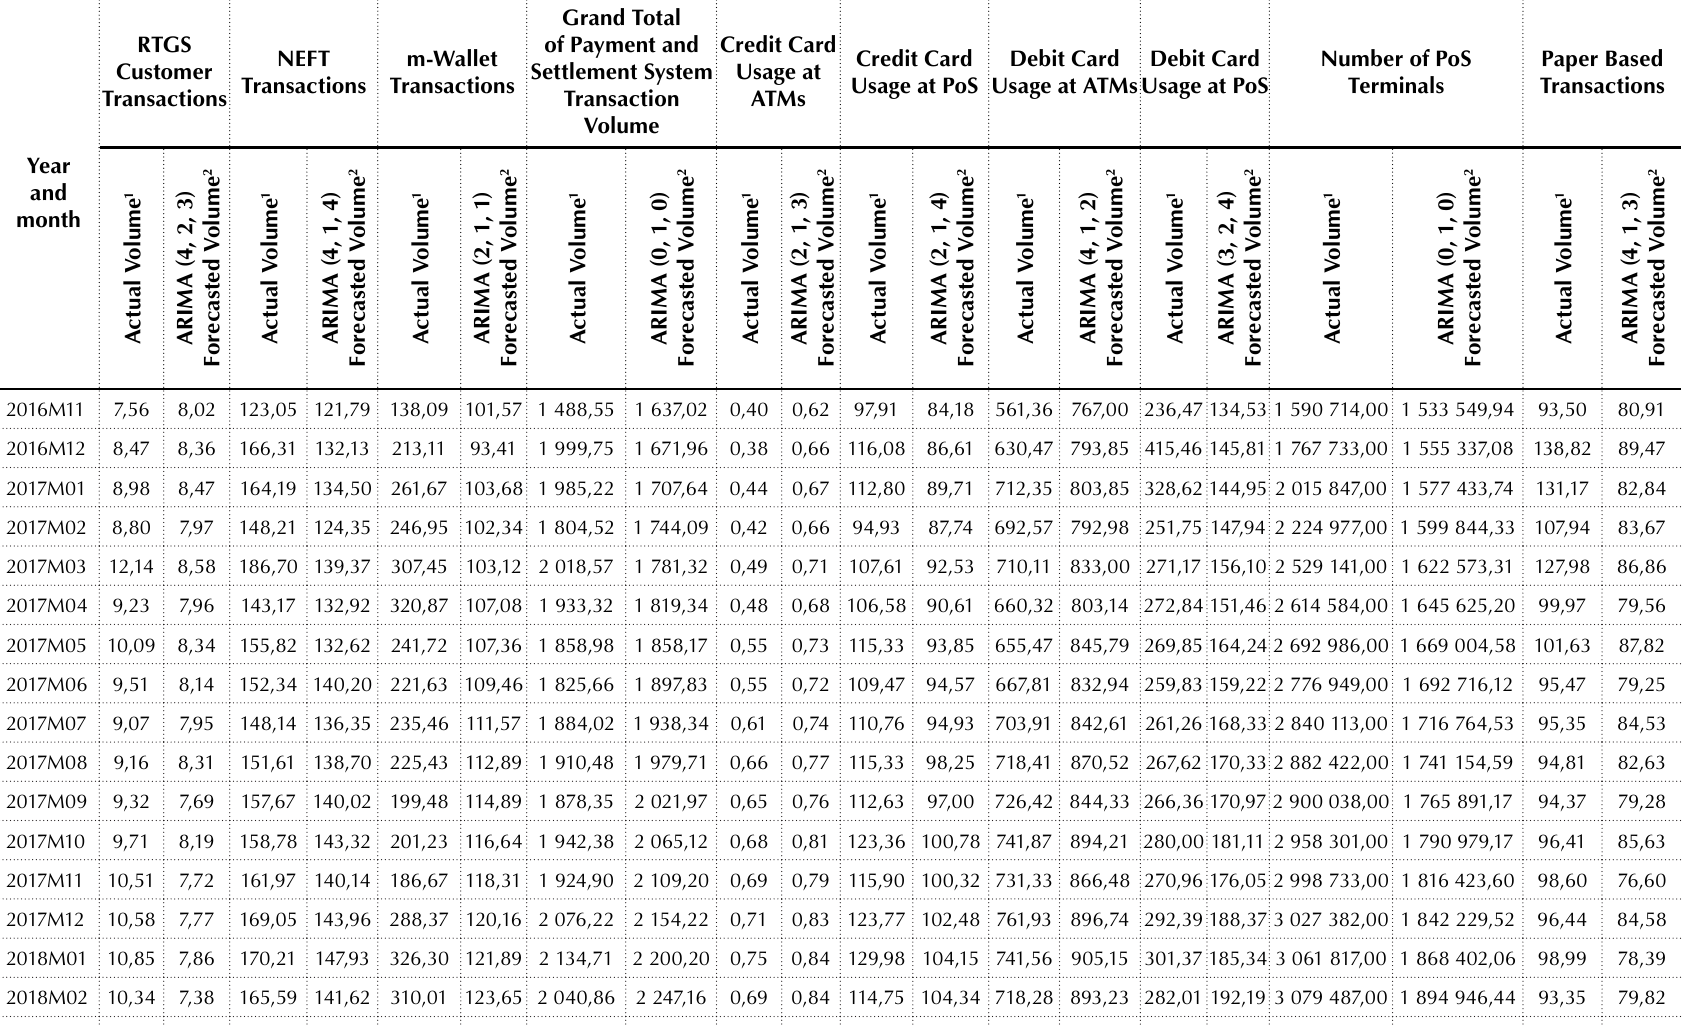
Table 2. ARIMA (p, d, q) estimations and actual volume of transactions (November 2016 to March 2018) Sources: 1 The data used for the study downloaded from the database on Indian economy available at https://dbie.rbi.org.in/DBIE/dbie.rbi?site=home . 2 Estimated by the